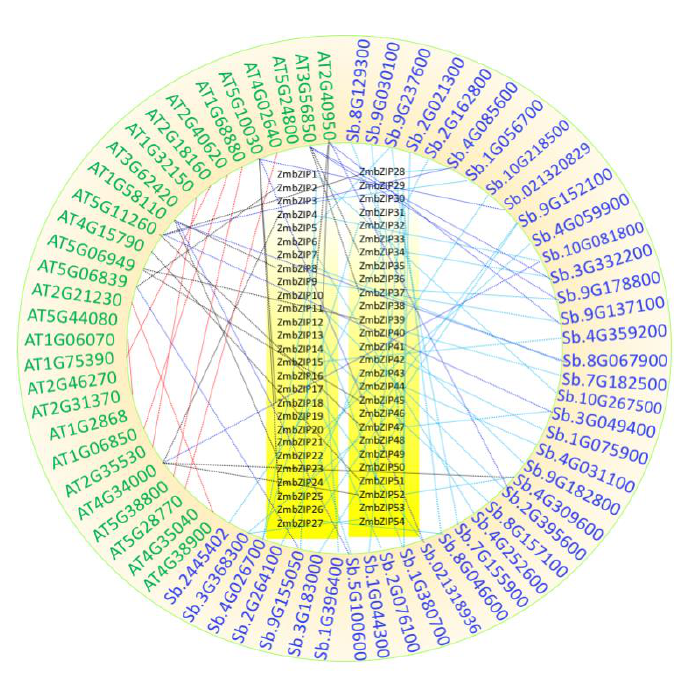
Figure 5. Collinearity relationships of bZIP genes among maize, sorghum, and Arabidopsis . Locus names from maize, sorghum, and Arabidopsis are marked with black, blue, and green fonts, respectively. Black, light blue, and dark blue lines indicate the orthologous pairs between maize and Arabidopsis , sorghum and maize, as well as sorghum and Arabidopsis , respectively. In addition, the paralogous Arabidopsis uses red lines.